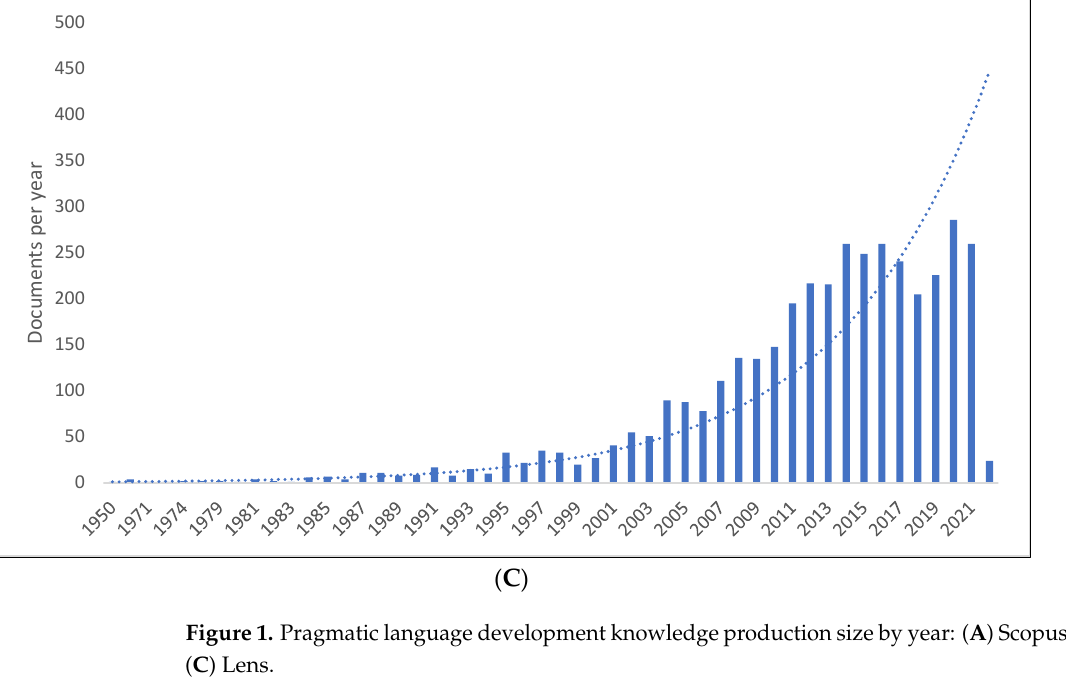
Figure 1. Pragmatic language development knowledge production size by year: ( A ) Scopus; ( B ) WOS; ( C ) Lens.